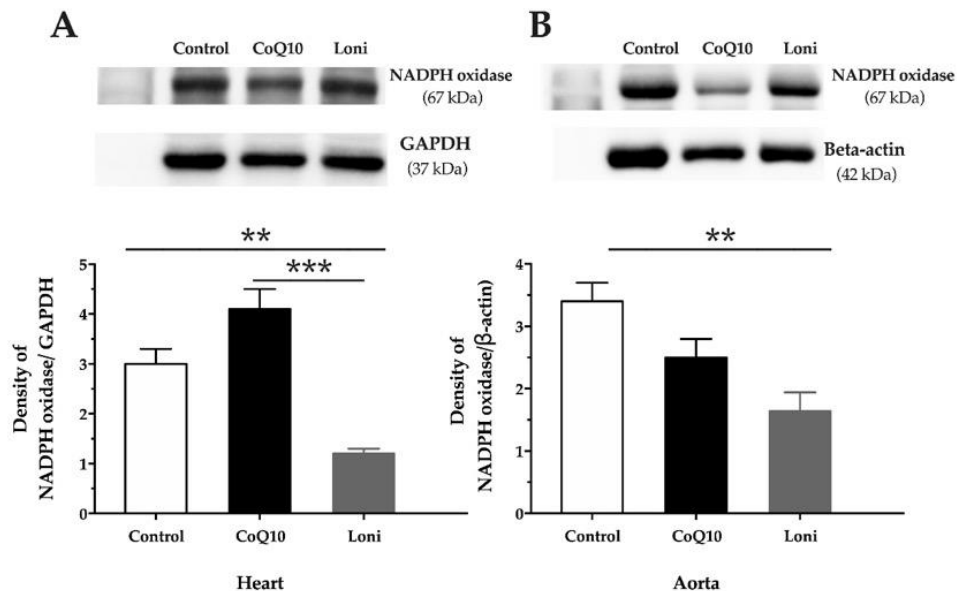
Figure 4. NADPH oxidase protein expression in the heart ( A ) and aorta ( B ). CoQ10; coenzyme Q10, Loni; Lonicera caerulea L. Heart; F (2.15) = 23.100, p = 0.00003; aorta; F (2.15) = 9.4086, p = 0.00225. ** p < 0.01 compared to the control group, *** p < 0.001 compared to the coQ10 group. Data are means ± SEM from 6 animals in each group.